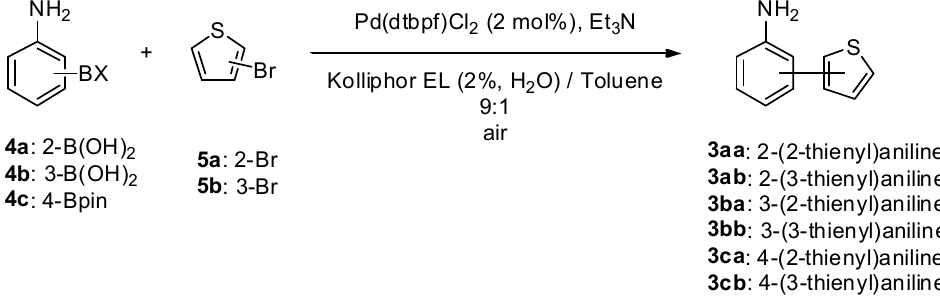
Scheme 2. Micellar Suzuki cross-coupling between aniline boronic acids and esters and bromo-thiophenes.